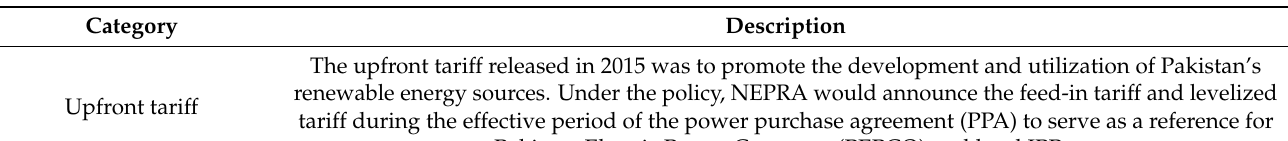
Table 2. Preferential tariff policies for photovoltaic power